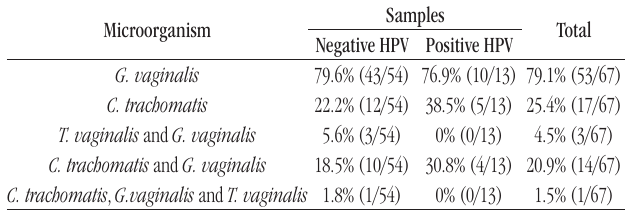
taBLE 2 − Coinfection with HPV, Chlamydia trachomatis , Gardnerella vaginalis and Trichomonas vaginalis in self-collected samples of vaginal canal